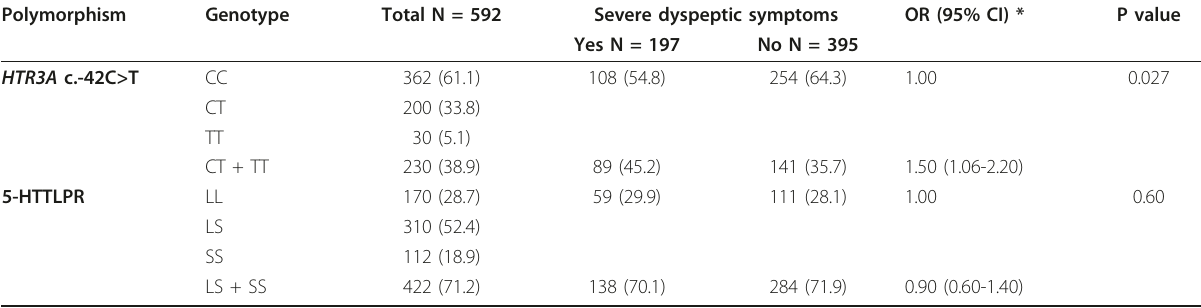
Table 3 Association of HTR3A c.-42C > T and 5-HTTLPR genotypes with dyspeptic symptom severity Polymorphism